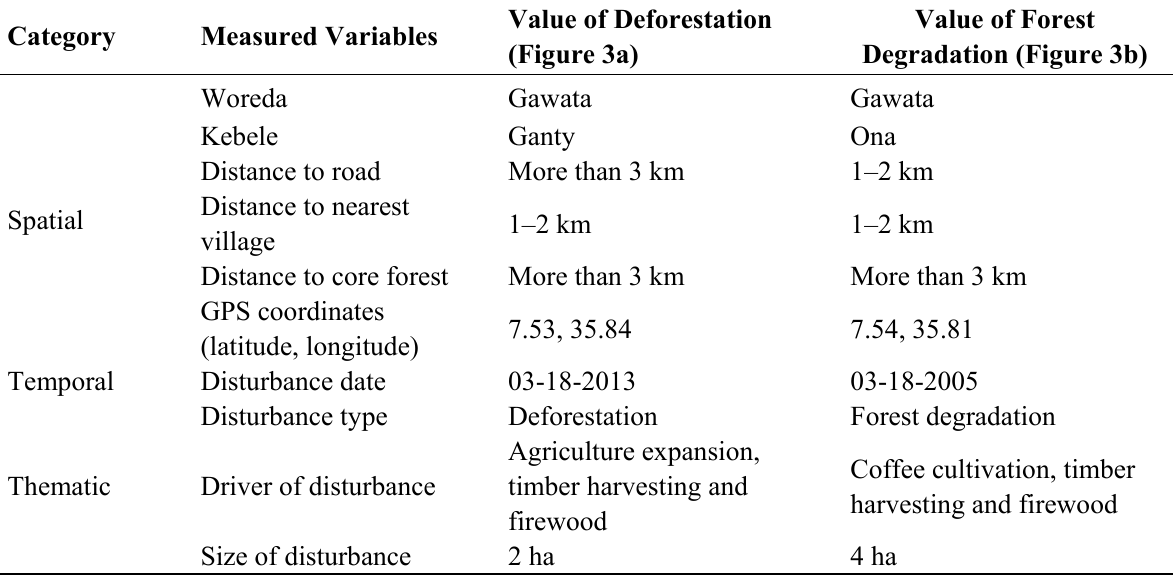
Table 3. Attribute tables derived from local expert observations of deforestation and forest degradation (shown in Figure 3a,b,